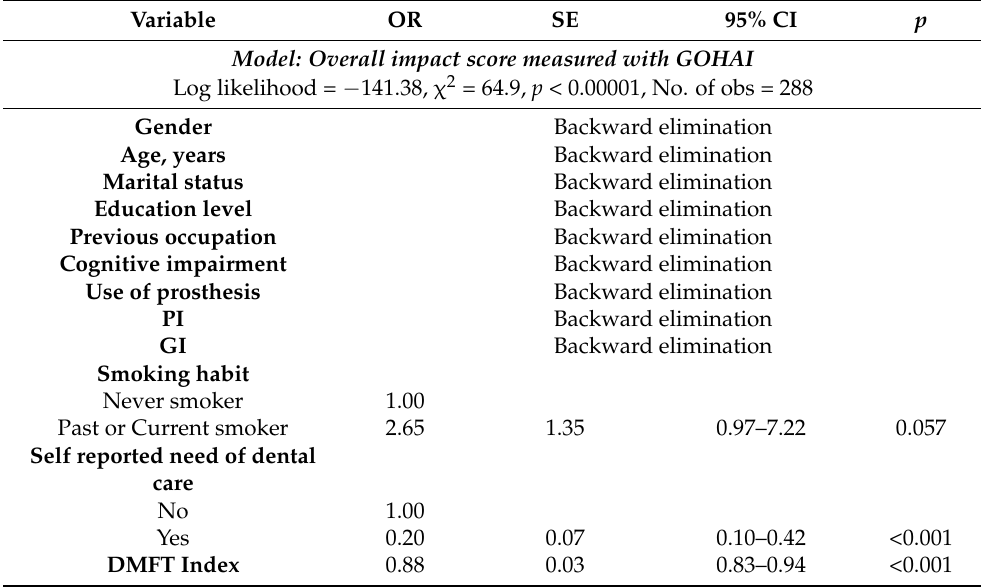
Table 3. Multiple logistic regression analysis results examining GOHAI score according to sev- eral